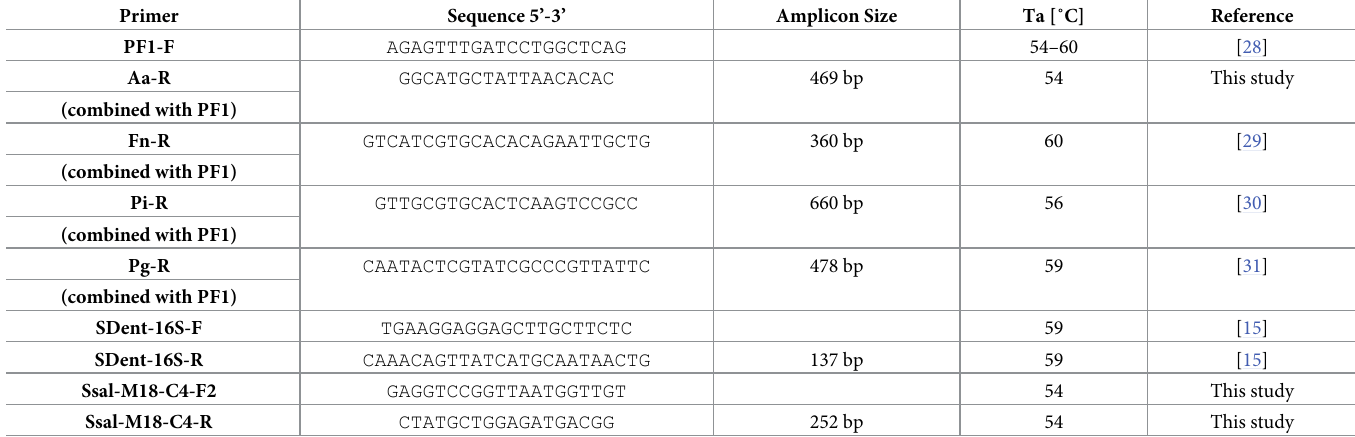
Table 1. List of primers used in this